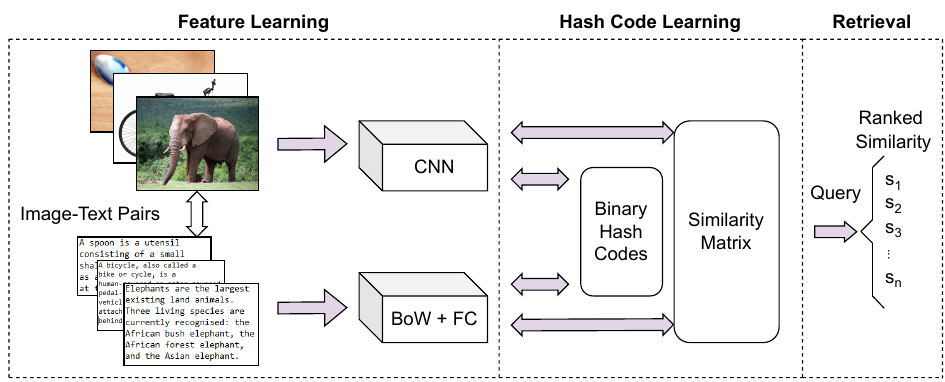
Figure 2. Overview of an end-to-end deep hashing architecture. This figure illustrates a simplified recreation of the Deep Cross-Modal Hashing (DCMH) [9] network architecture (CNN: Convolutional Neural Network, BOW: bag of words, FC: Fully Connected layers). Example elephant (1), bicycle (2) and spoon (3) images reprinted under Creative Commons attribution, (1) Title: Elephant